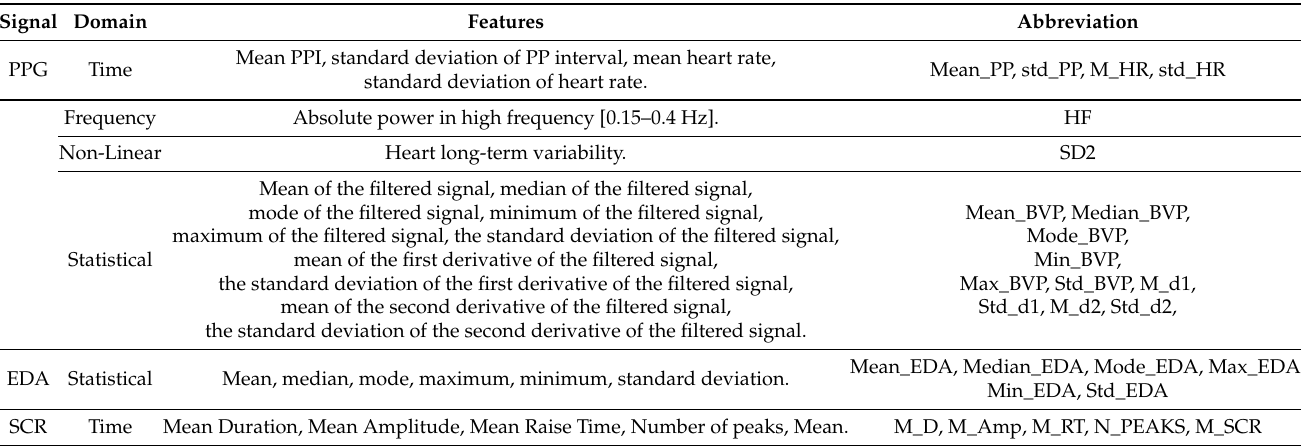
Table 2. All the features computed with their domain and